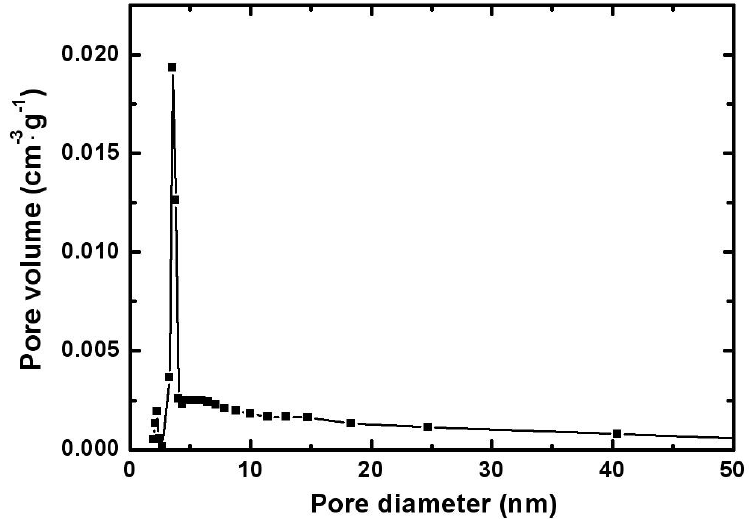
Figure 2. Pore size distribution of the electrodeposited Mn-Ni oxide film.